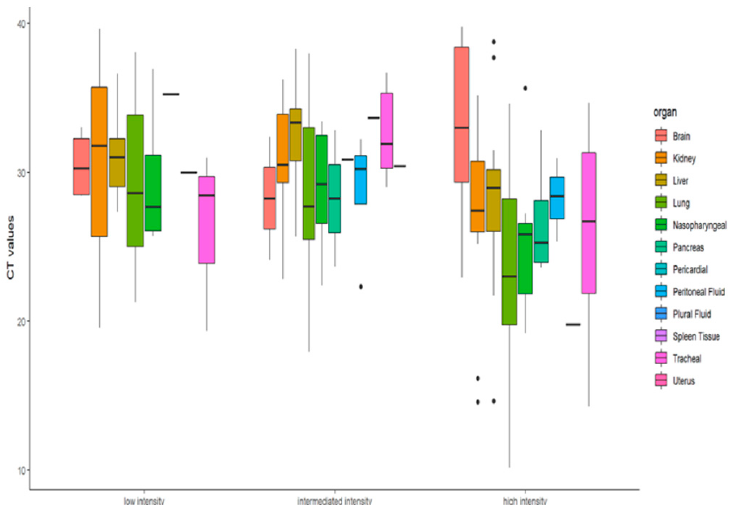
Figure 5. Boxplot representation of the Ct values of infected organs as per the organ involvement. Though COVID-19 is associated with the respiratory system, we demonstrate presence of SARS-CoV-2 other vital organs as well. The site of lodgment for SARS-CoV-2 is nasophar- ynx, which being contiguous to lungs makes them the primary target organ, and lungs were the only organ from which SARS-CoV-2 was detected by RT-PCR in all 21 autopsied cases. Hence, correlation could be drawn only between the Ct value of SARS-CoV-2 in lungs and organ involvement. The organotropism associated with this infection is a direct function of the viral load in the lungs. This means that higher the viral load in the lungs (lower Ct value), the more the infection will spread in other extrapulmonary organs [37]. Therefore, the percentage of organ involvement for each case was correlated with viral RNA in the lungs (lungs qRT-PCR Ct value) Figure 6. Spearman’s rank correlation test showed a negative correlation of − 0.65 with T statistics of 3.74 and significant p value of 0.0013. This suggests that higher pulmonary viral RNA (i.e., lower Ct value) corresponds to high percentage of organ involvement, contributing to the broad virus dissemination in case of